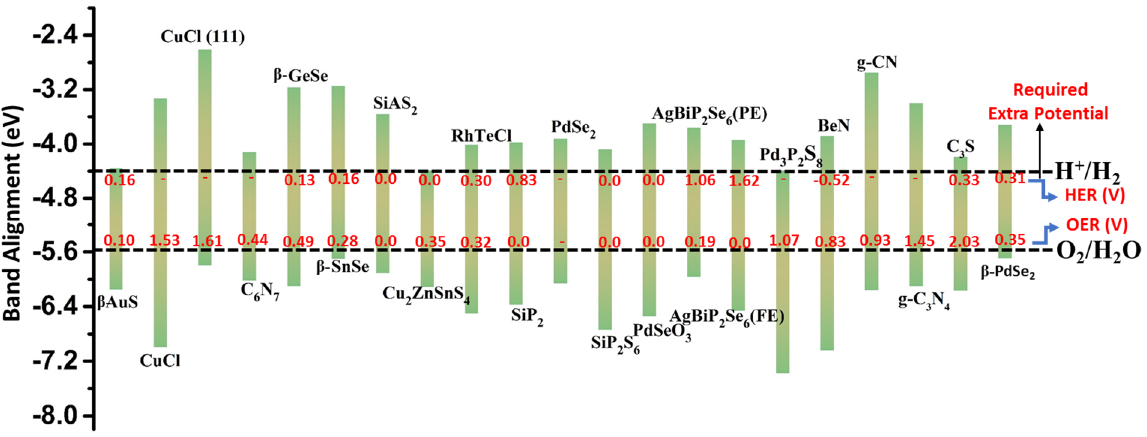
Figure 3. Band alignments and required extra potential of some typical 2D materials concerning the water reduction and oxidation potential for photocatalytic water-splitting.